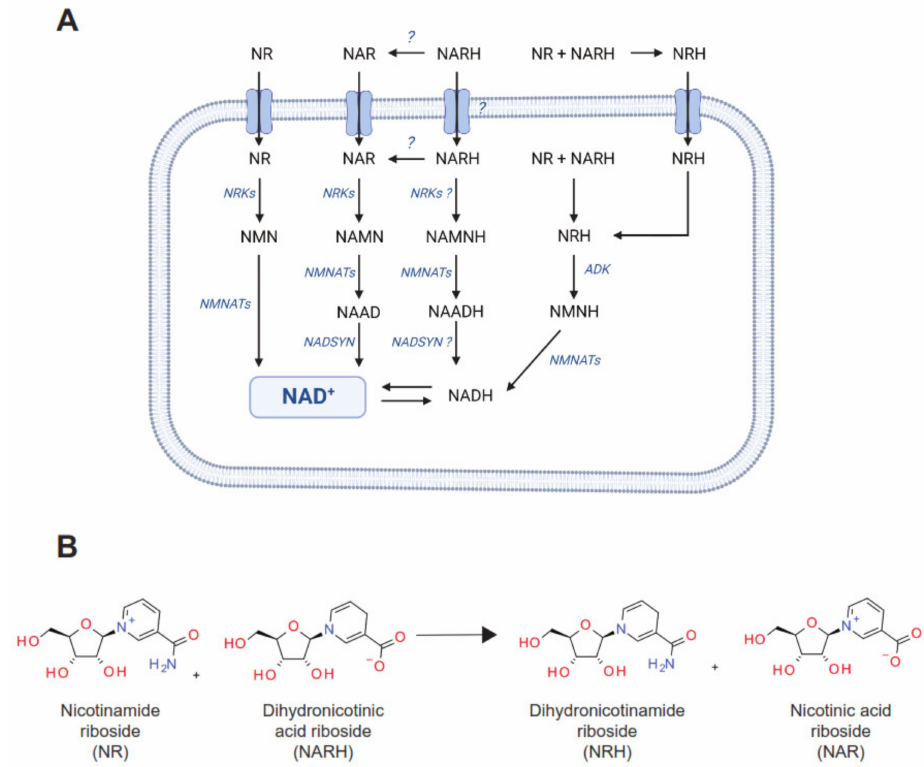
Figure 7. Different paths towards NAD + synthesis from ribosylated NAD + precursors. ( A ) Nicoti- namide riboside (NR), nicotinic acid riboside (NAR) and their respective reduced forms, dihydroni- cotinamide riboside (NRH) and dihydronicotinic acid riboside (NARH), act as ribosylated NAD + precursors. Ribosylated NAD + precursors are characterized by having a ribose moiety already bound to the nicotinamide (NAM) or nicotinic acid (NA) rings (see ( B )). After entering the cell, NR is phosphorylated by NR kinases (NRKs), generating nicotinamide mononucleotide (NMN), which is then used by the NMN adenylyltransferase enzymes (NMNATs) to generate NAD + . NRKs also initiate the path of NAR towards NAD + synthesis by generating NA mononucleotide